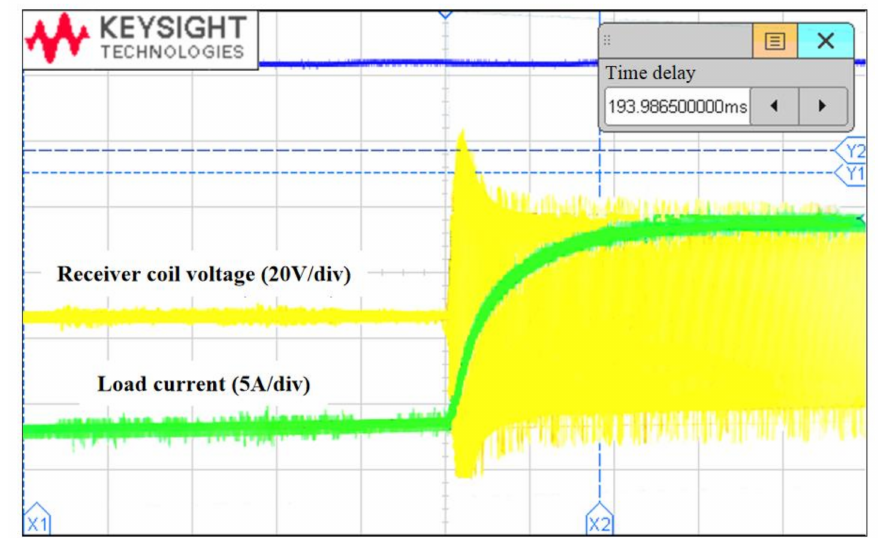
Figure 15. Variation of receiver coil voltage and load current during the system